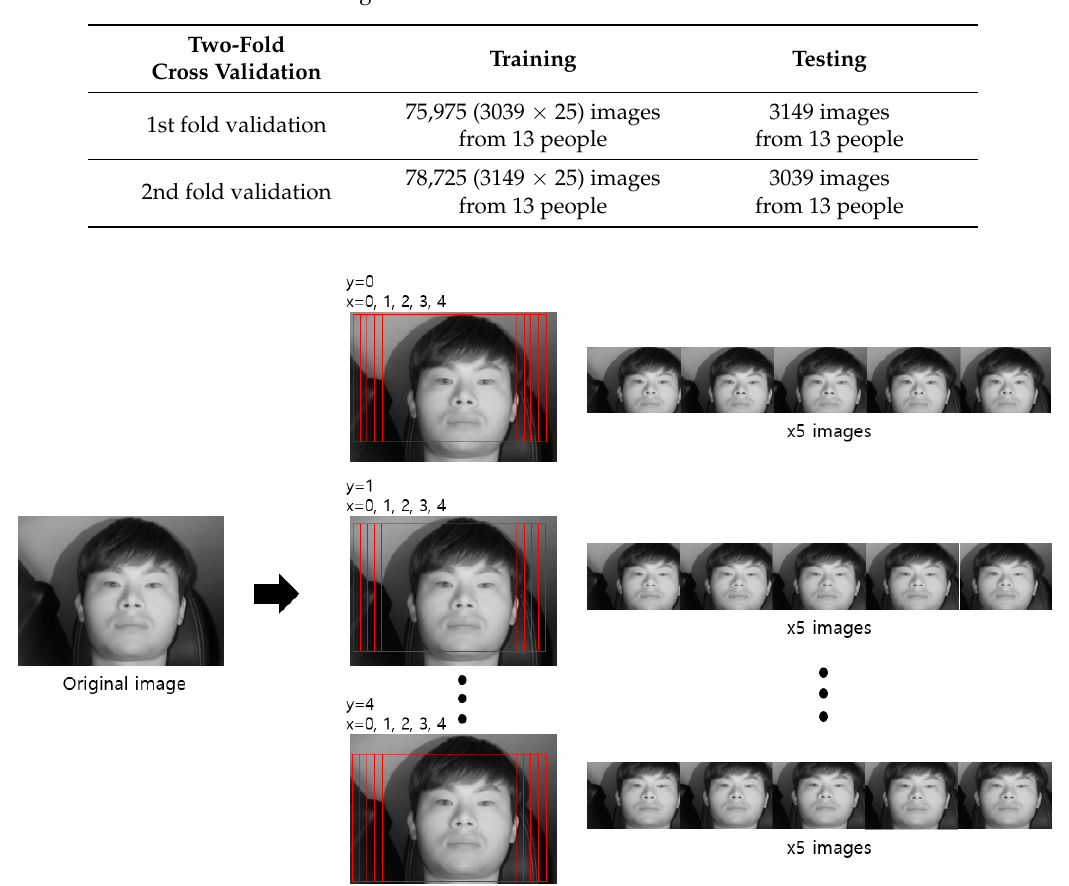
Table 5. Image database for the evaluation of shallow CNN.